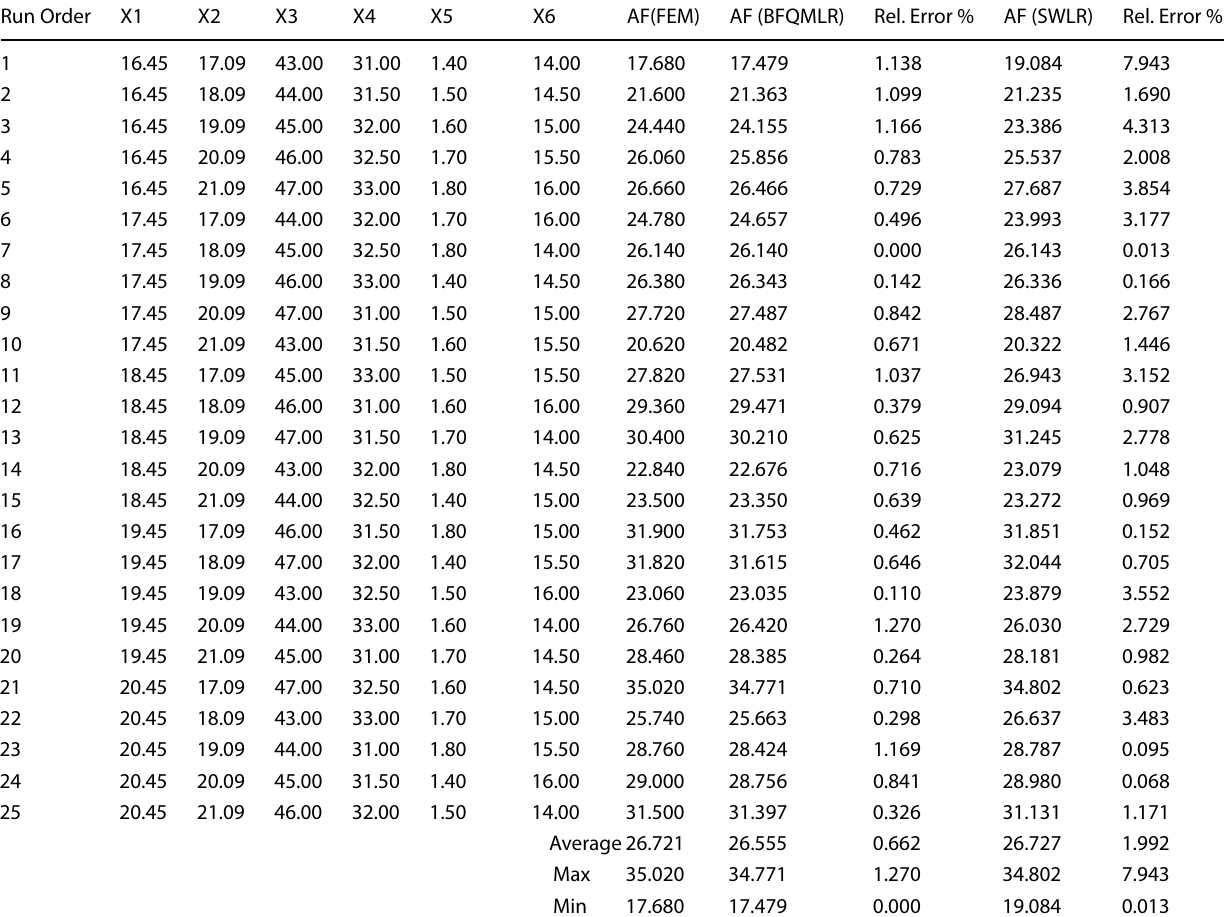
Table 9 Validity check for regression models of AF Run